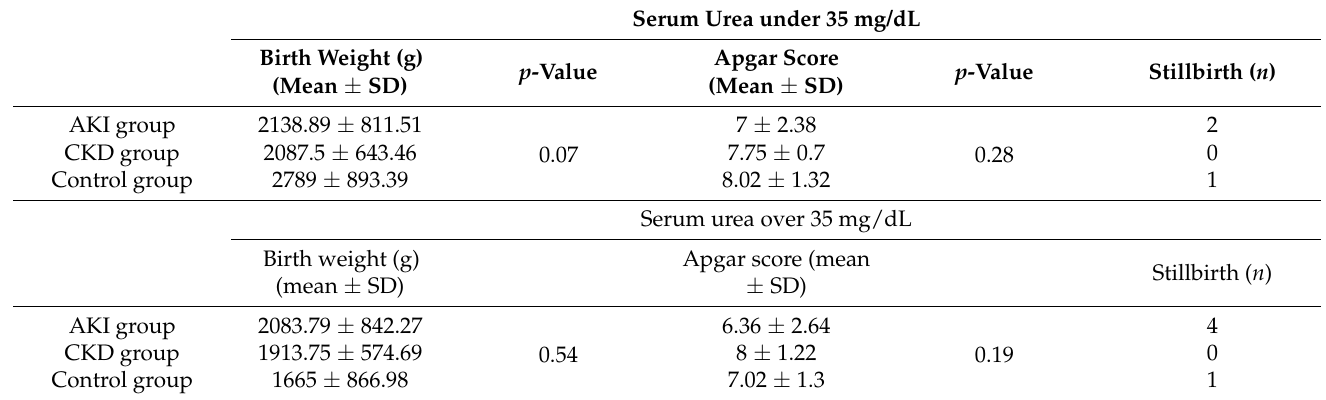
Table 6. Neonatal characteristics by a threshold value of serum urea. Serum Urea under 35